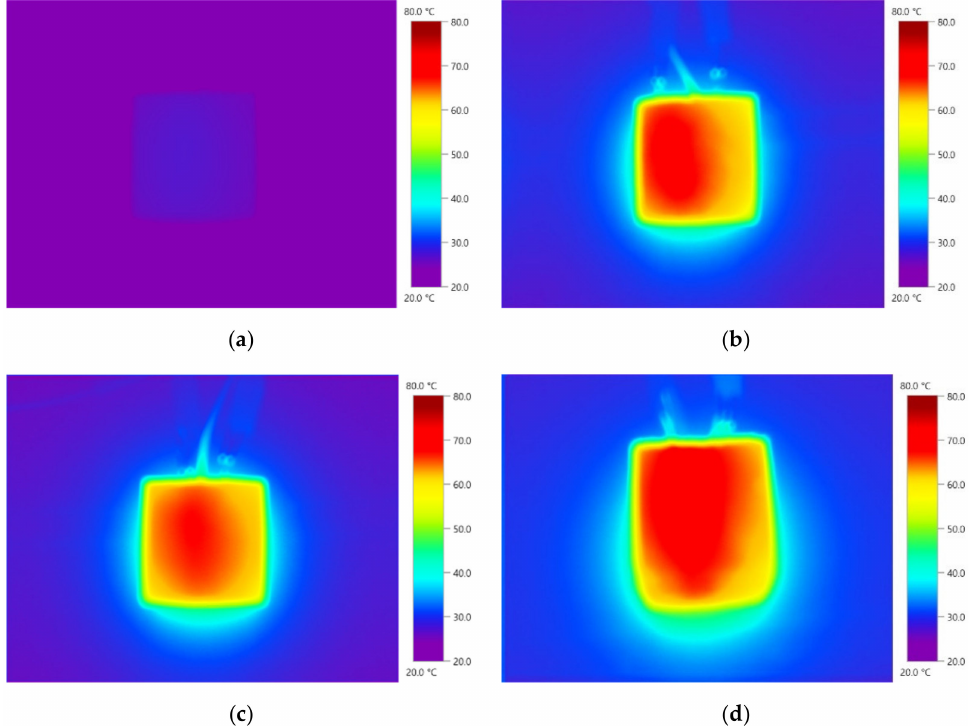
Figure 7. Thermal images of the nanocementitious composites with 0.5 wt% (60 V): ( a ) OPC; ( b ) GNP- 0.5; ( c ) CB-0.5; ( d )